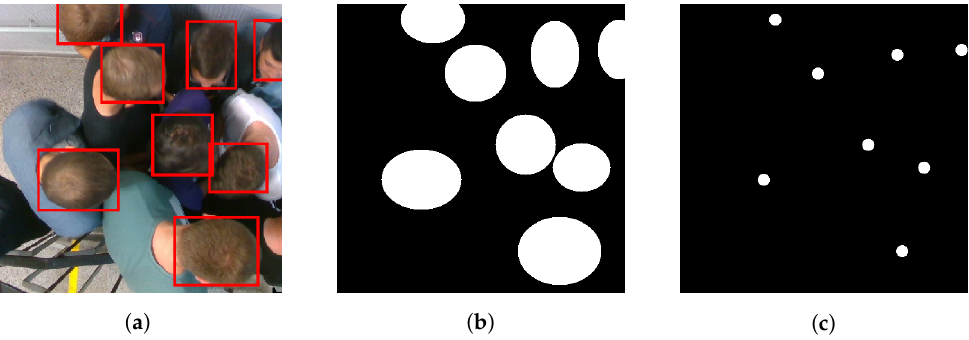
Figure 6. The preparation of the ground truth. ( a – c ) respectively represent an example of: original bounding boxes superimposed on its raw image, the ground truth of system 1, and the ground truth of system